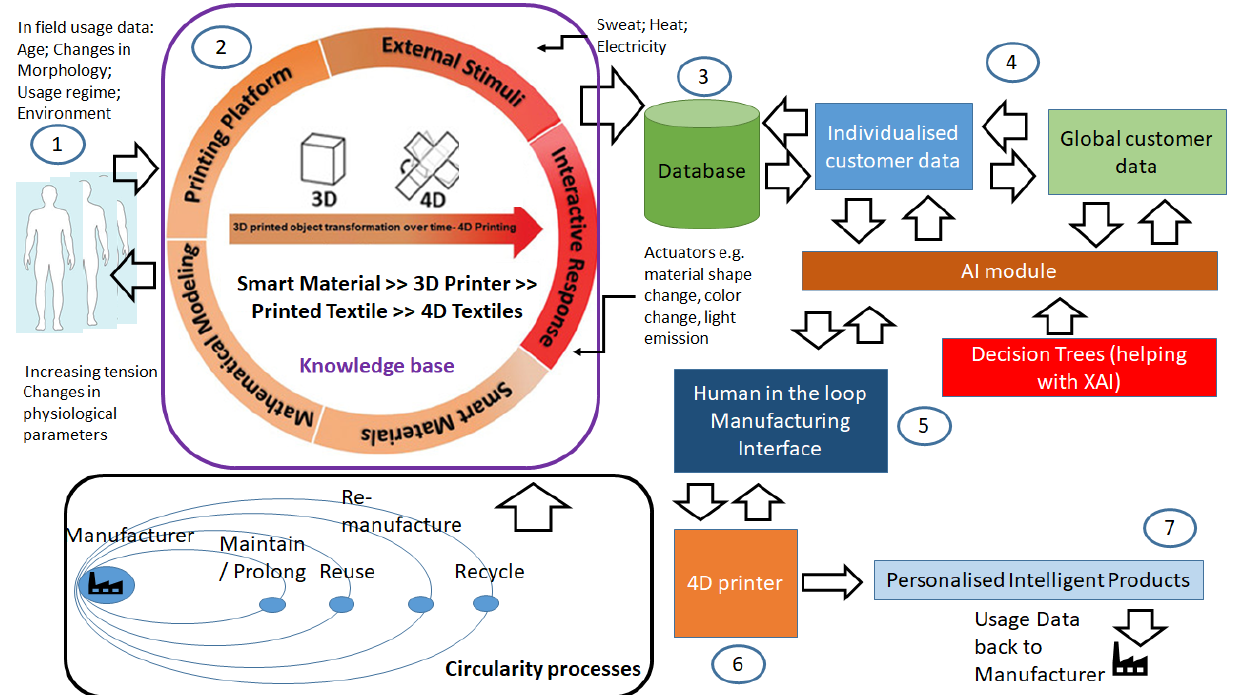
Figure 1. Framework for circular production of additively manufactured personalised products.